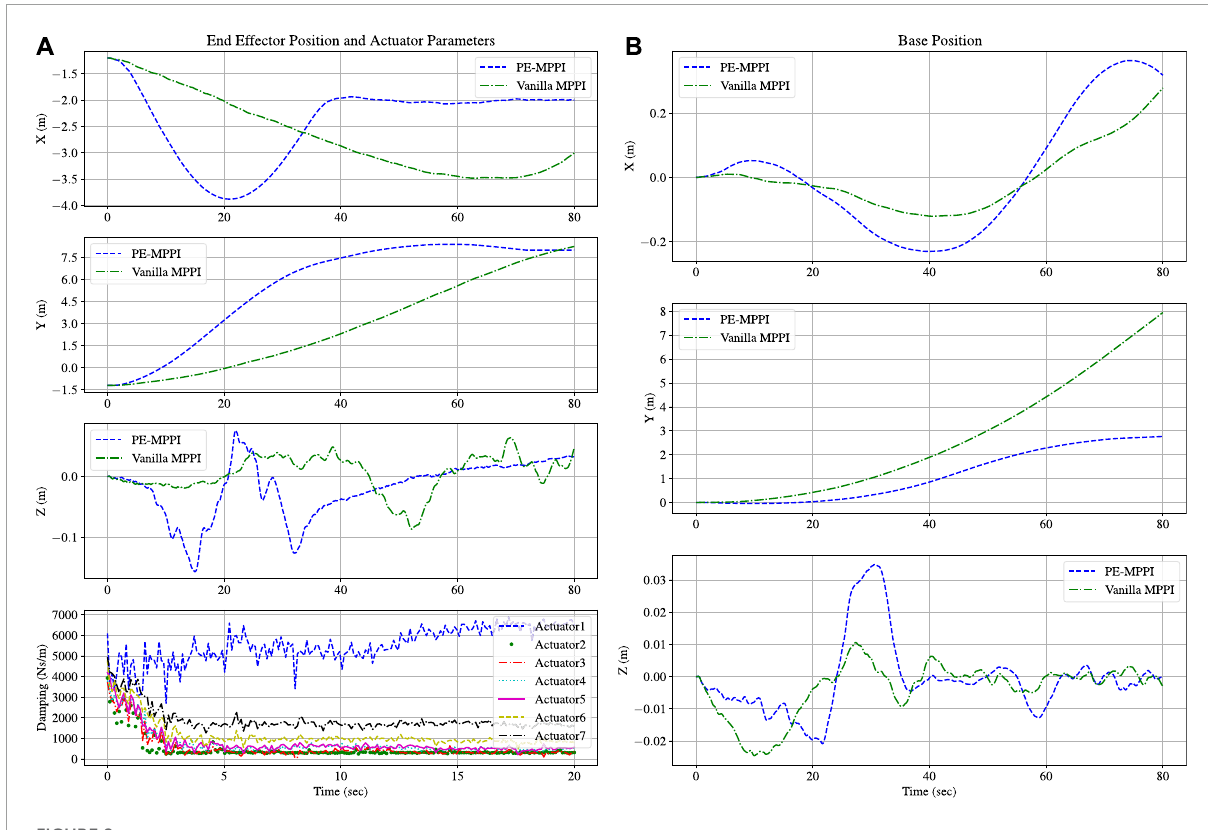
FIGURE 8 System identification and actuator failure scenario; Comparison between PE-MPPI and vanilla MPPI for the end-effector position (A; Top) . Convergence of the parameters of the on-board model to the real system (A; Bottom) Comparison between PE-MPPI and vanilla MPPI for the space robot base position (B)